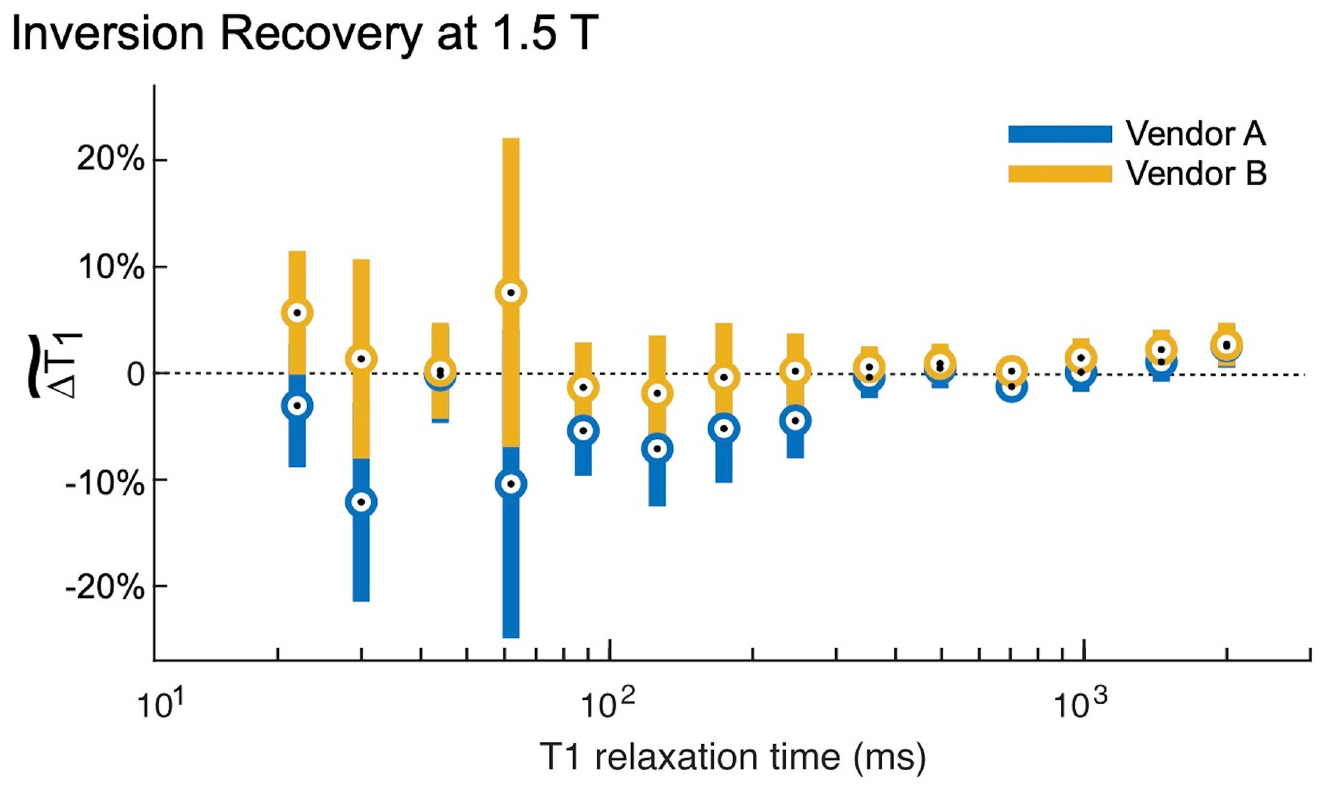
Fig 2. Inversion recovery measurements at 1.5 T. The inversion recovery (IR) measurements at 1.5 T both over- and underestimated the T 1,NMR . The circles represent the within group means, and the error bars are 95% confidence intervals about these means. The IR measurements, especially in the range of physiological T 1 values (~250 ms for adipose tissue to 1800 ms for grey matter) are biased approximately 5% high. Both vendors exhibited this bias; there are no significant differences between them throughout the entire range of T 1 times spanned by the ISMRM/NIST phantom array (Table 4).